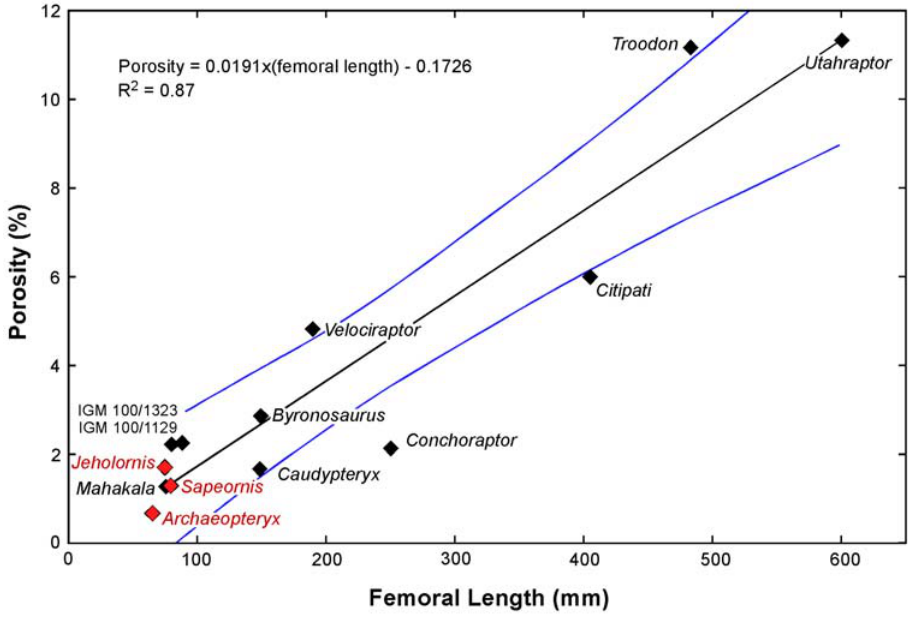
Figure 6. Maniraptoran femoral porosity shown with respect to scale. Intracortical transverse plane porosity from the histological sections was quantified (See Materials and Methods). These data are plotted with respect to femoral length. Data for non-avialan taxa are denoted by black diamonds. The regression equation describes only their distribution. The blue lines bound the 95% confidence interval. The red diamonds represent the basalmost avialans studied here. Note: their data are encompassed by the maniraptoran confidence interval and that for sister taxon Deinonychosauria (not shown).